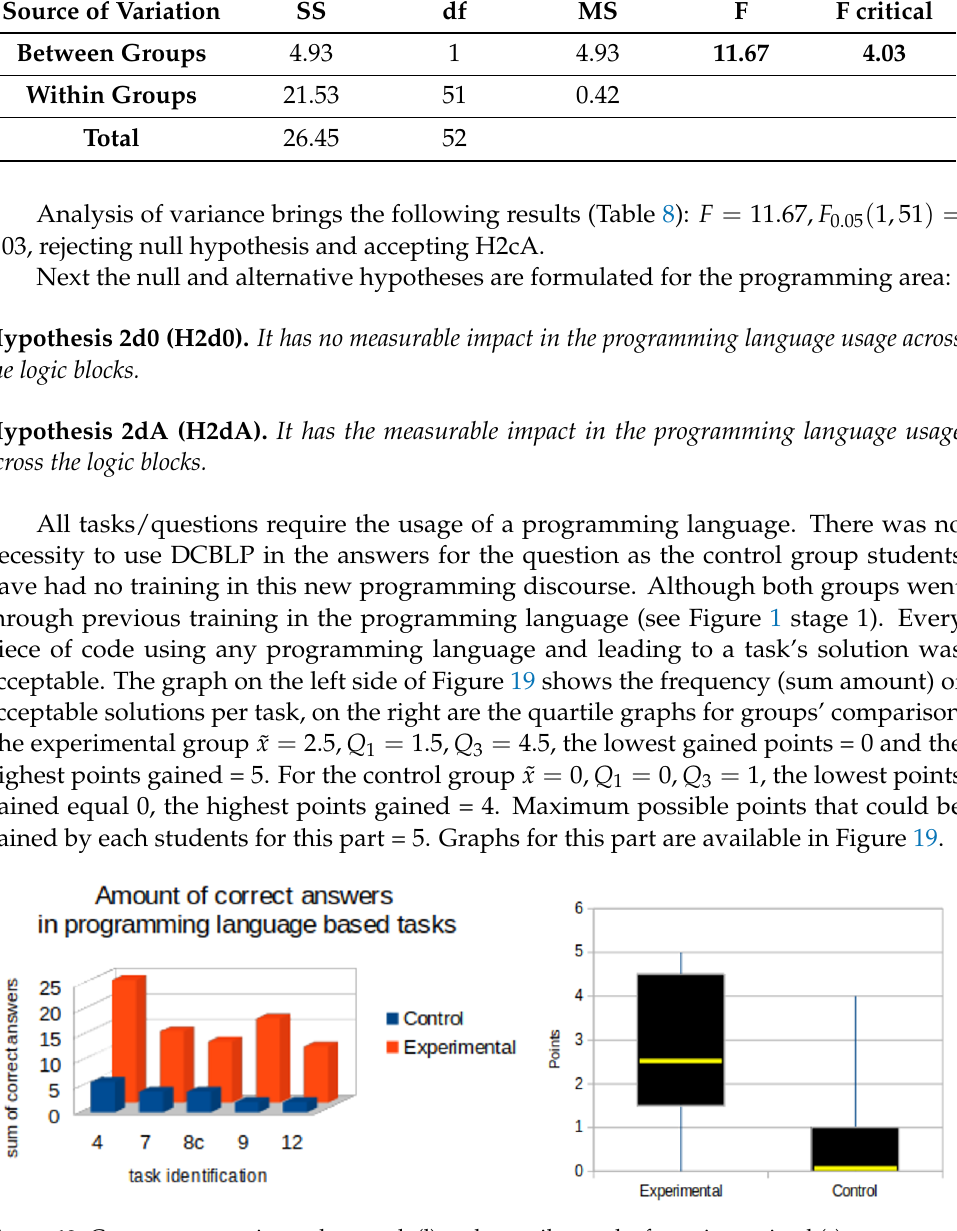
Figure 19. Correct answers in total per task (l) and quartile graphs for points gained